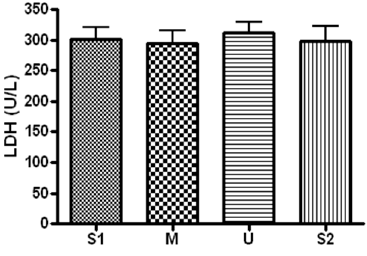
Figure 6. Serum LDH concentration in different locations. Values are mean ± S.D. S1: Before start in Seoul, M: Moscow U: Ulaanbaatar S2: Return to Seoul.